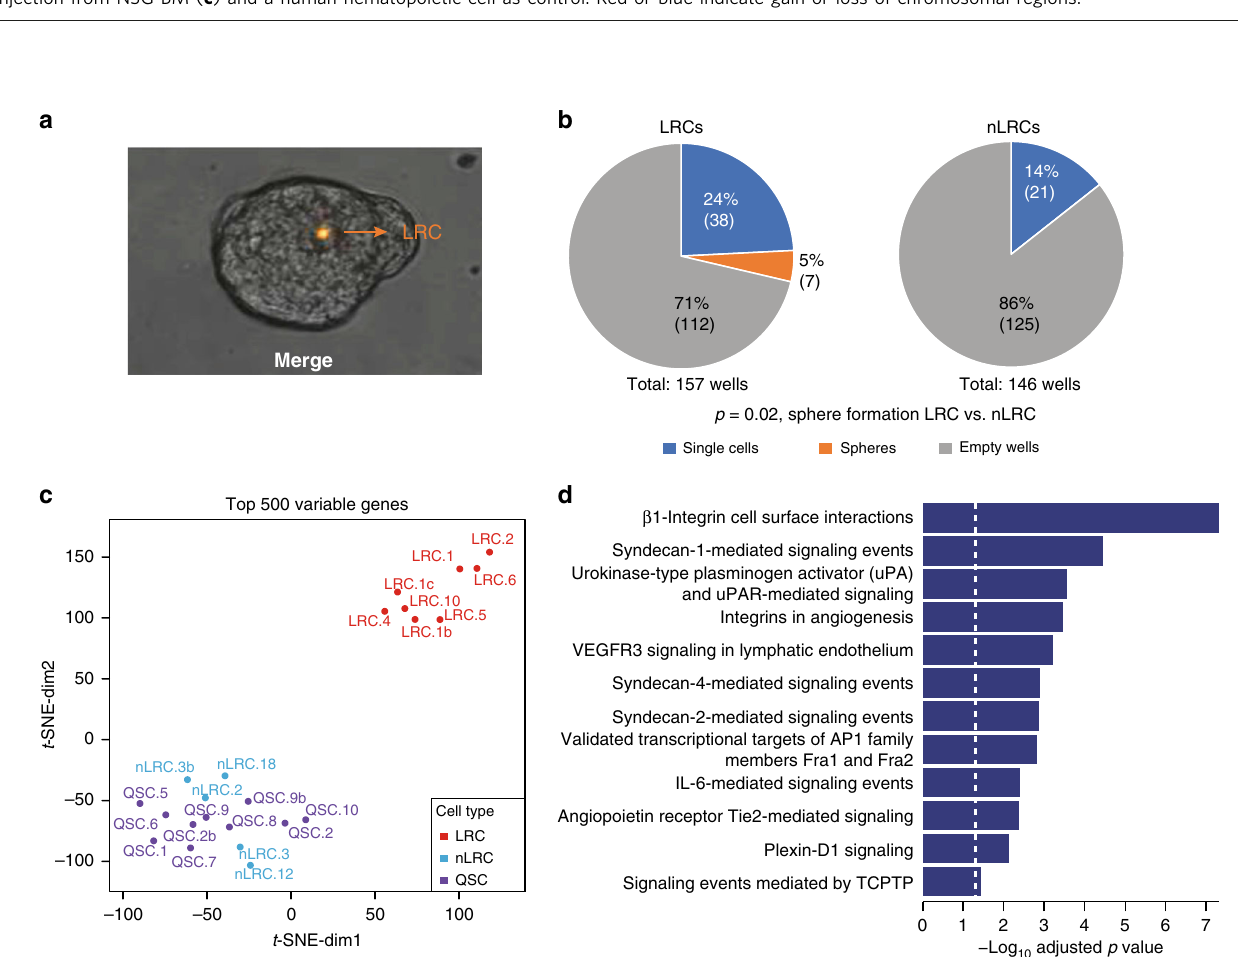
Fig. 2 IL6 pathway is activated in mammary stem cells. a Representative picture of a mammosphere (day 7) generated from PKH26-labeled HMECs. b PKH26-labeled HMEC-mammospheres from four patients were disaggregated, sorted by fl owcytometry into PKH26 + LRCs and PKH26- nLRCs, plated as single cell per well, and tested for sphere-formation. Shown is the percentage and in parentheses the respective absolute number of empty wells, wells with single cells and spheres after two weeks of mammosphere-culture (number of spheres vs. no spheres for LRCs vs. nLRCs, p = 0.02, two-sided Fisher ’ s exact test). c , d LRCs ( n = 8), nLRCs ( n = 5) and QSCs ( n = 10) from three patients were subjected to single cell transcriptome microarray analysis. c t-SNE plot of the top 500 most variable genes. d Pathway analysis using the 216 genes differentially expressed between LRCs and the pooled nLRCs plus QSCs. See Supplementary Table 1 for patient/sample-ID allocation.